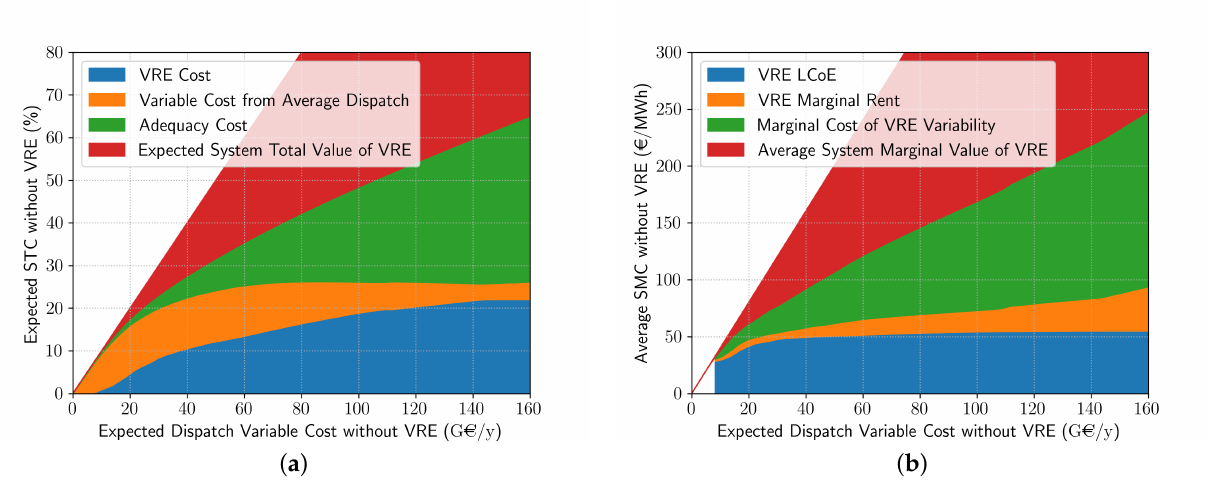
Figure 9. ( a ) Decomposition of the expected system total cost without Variable Renewable Energy (VRE). The blue and the orange areas, respectively, represent the VRE fixed cost (Equation (2)) and the variable dispatch cost due to the average residual load and add up to the constant version of the expected System Total Cost (STC, second term in Equation (16)). The green area is filled between the constant and the variable versions of the expected STC and represents the adequacy cost (Equation (17), third term in Equation (16)). Finally, the red area is filled between the variable version of the expected STC and the expected STC without VRE and thus represents the expected system total value of VRE (Equation (16)). ( b ) Decomposition of the average System Marginal Cost (SMC) without VRE. The blue area represents the VRE levelized cost of electricity (Equation (19), last term in Equation (22)). The orange area represents the value of the VRE marginal rent (Equation (20), third term in Equation (22)). The green area represents the marginal cost of VRE variability (second term in Equation (22)). Finally, the red area is filled between the variable version of the average SMC and the average SMC without VRE and thus represents the average system marginal value of VRE (Equation (22)).